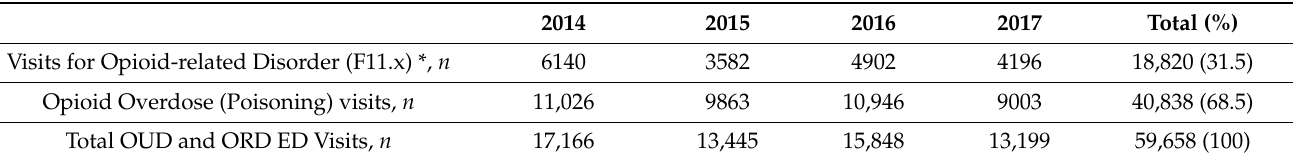
Table 1. Frequency of pediatric ED visits for opioid-related disorders (OUD) and opioid overdose (OD) in any diagnosis field, 2014–2017 NEDS data.